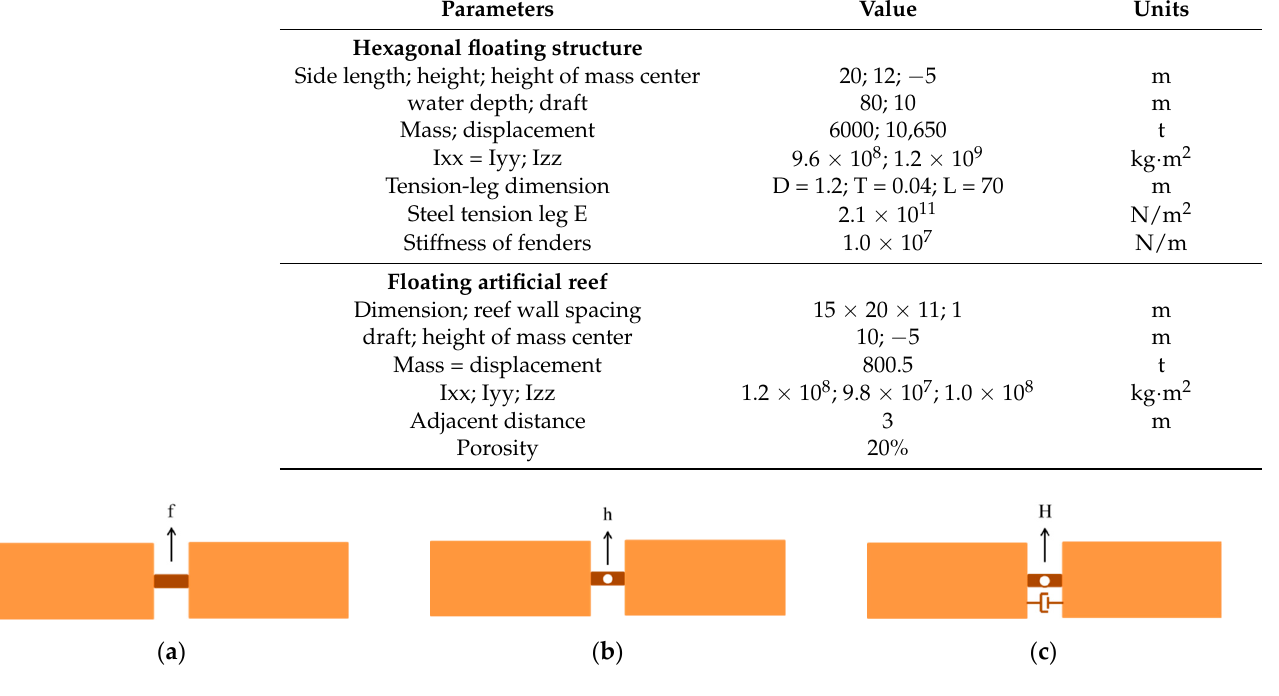
Figure 2. The sketch of three connector types: ( a ) fixed connector; ( b ) hinge connector; ( c ) hinge connector with a pitch damper.